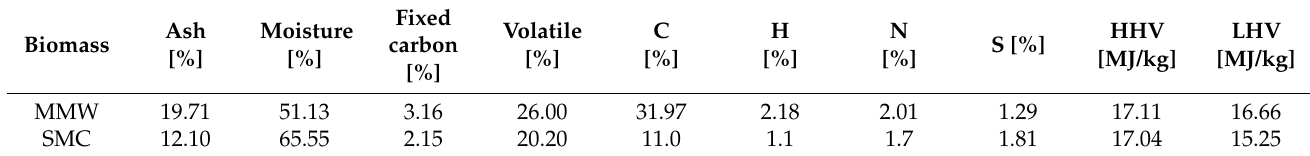
Table 3. Proximate and ultimate analysis of SMC and its mixture with woodchips MMW.